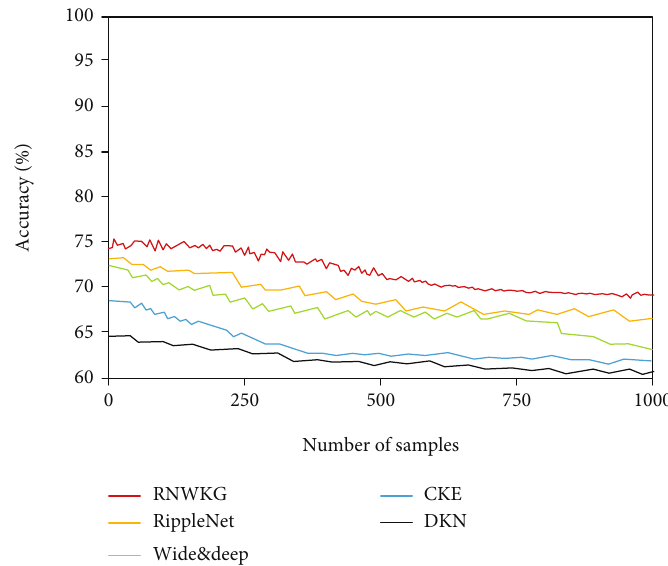
Figure 8: Comparison of accuracy of fi ve models in